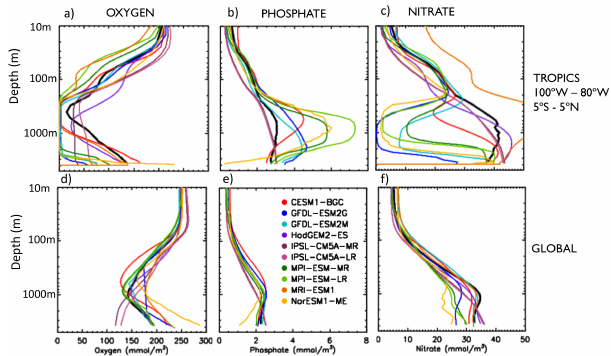
Figure 3. Average vertical profiles of (a) oxygen, (b) phosphate and (c) nitrate concentrations (mmolm − 3 ) from CMIP5 models (coloured lines – explained in the legend) and the WOA09 obser- vations (black line) in the eastern tropical Pacific region, spanning 80 to 100 ◦ W longitude and 5 ◦ N to 5 ◦ S latitude. (d) – (f) Analogous global averages. The model HadGEM2-CC (not shown) shows re- sults similar to